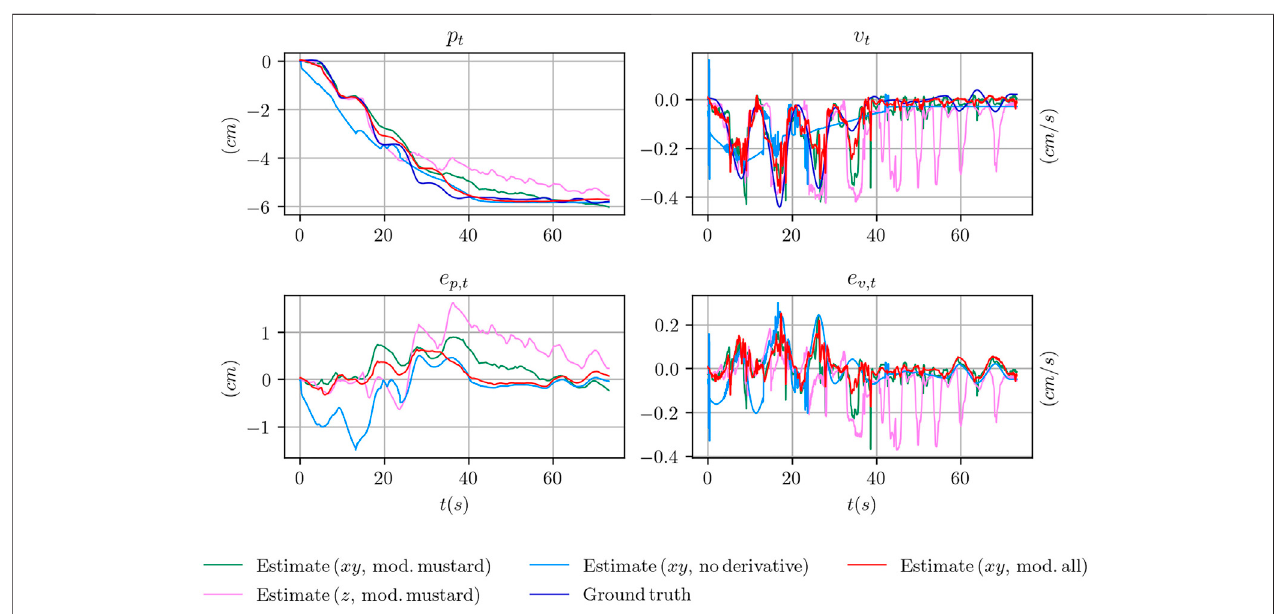
FIGURE 8 | Comparison of the position and velocity trajectories for several con fi guration of the tactile measurements with the ground truth state for the object mustard bottle.